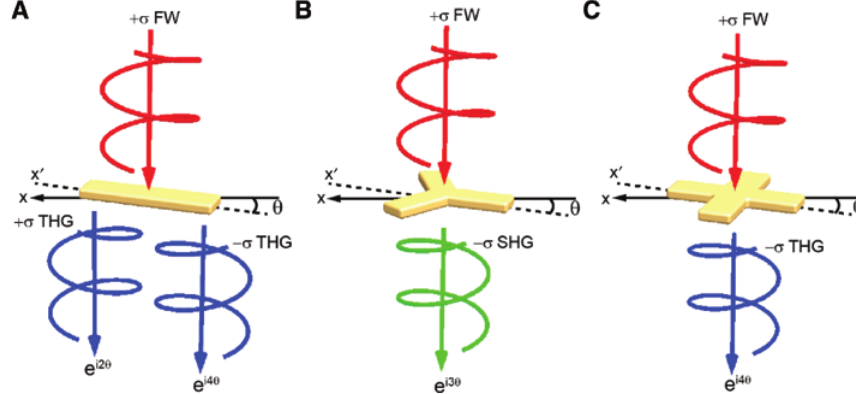
Figure 3: Nonlinear geometric P-B phase elements. (A–C) Nonlinear phase elements with two-, three-, and four-fold rotational symmetry (C2–C4). Based on the rotational symmetry, only par- ticular nonlinear processes and circular polarization states are allowed. (A) SHG from a C2 symmetric structure is forbidden; the P-B phases of 2 θ and 4 θ for the THG are observed. (B) For a C3 meta-atom, the P-B phase of SHG with opposite helicity compared to the FW is 3 θ . (C) SHG from C4 meta-atoms is forbidden, and the P-B phase for the THG with opposite circular polarization is equal to 4 θ . θ is the orientation angle of the meta-atom. A–C are adapted from Ref.